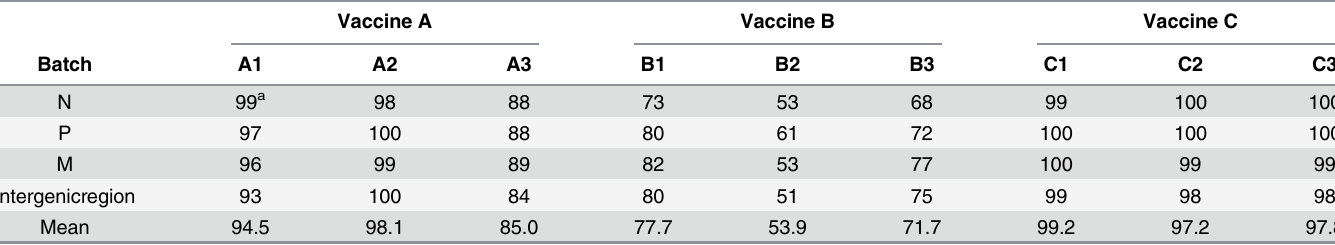
Table 2. Analysis of the nine vaccine sequences using 454 pyrosequencing. Vaccine A Vaccine B Vaccine